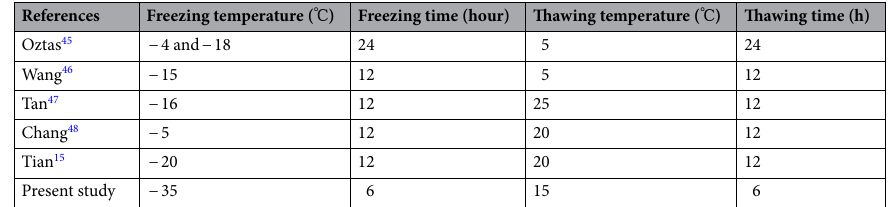
Table 3. Summary of freezing and thawing temperature and holding time from previous work.